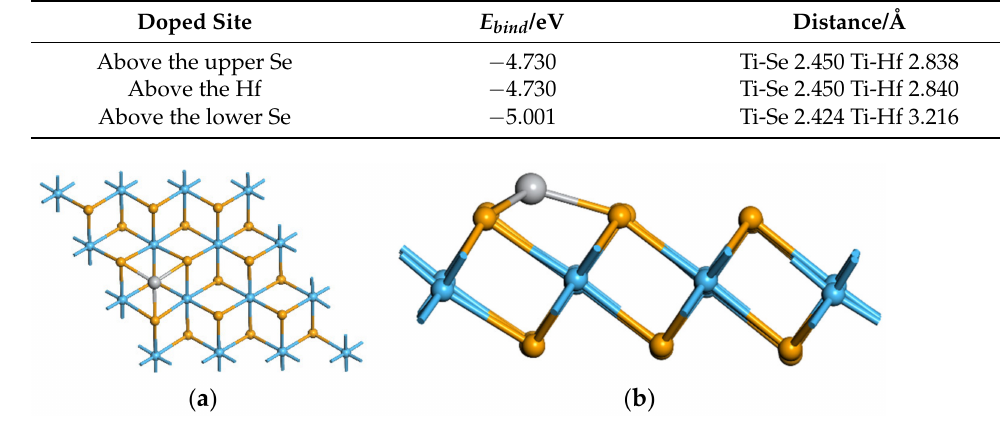
Figure 3. MSC of Ti − HfSe 2 . ( a ) Top view; ( b ) front view.